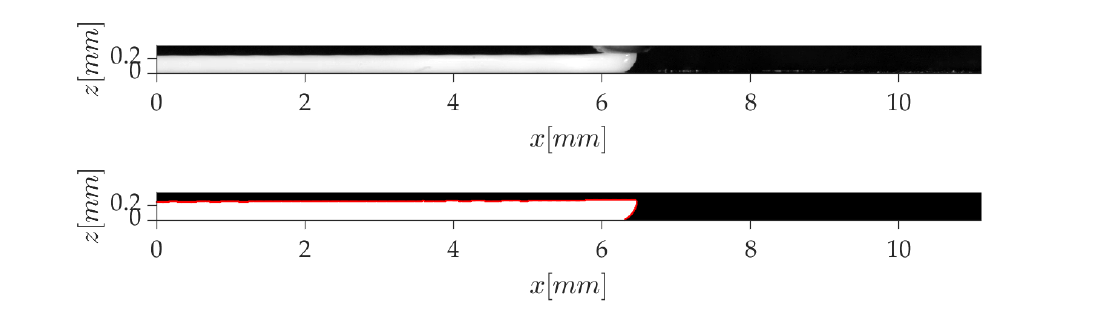
Figure 5. Detection of strand contours for the estimation of printing